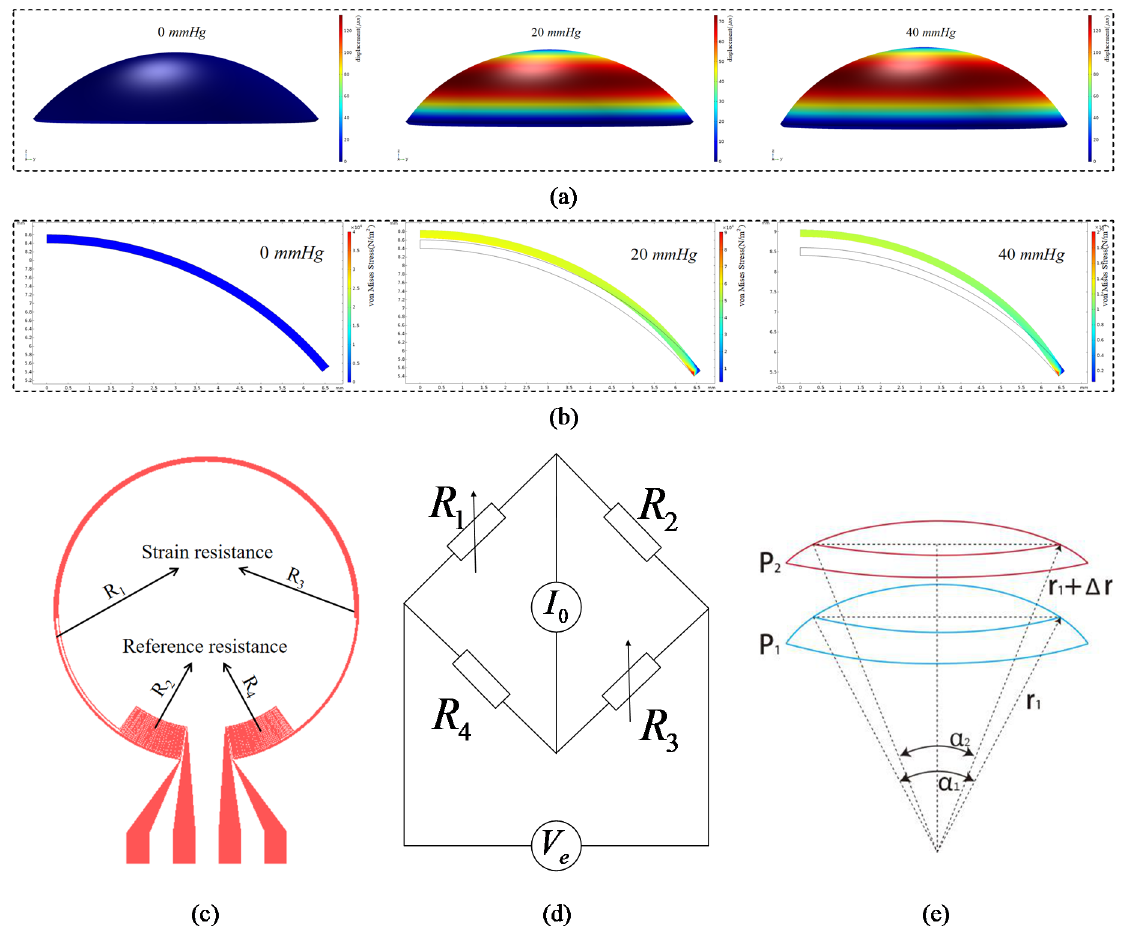
Figure 1. ( a ) Finite element simulation analysis of corneal deformation profile under the IOP of 0 mmHg, 20 mmHg and 40 mmHg. ( b ) Finite element simulation analysis of corneal von Mises stress distribution and deformation profile of cornea under the IOPs of 0 mmHg, 20 mmHg and 40 mmHg. ( c ) Strain gauge structure design diagram. ( d ) Wheatstone bridge schematic diagram. ( e ) Schematic diagram of contact lens deformation caused by changes in IOP, resulting in changes in the radius of curvature ∆ r